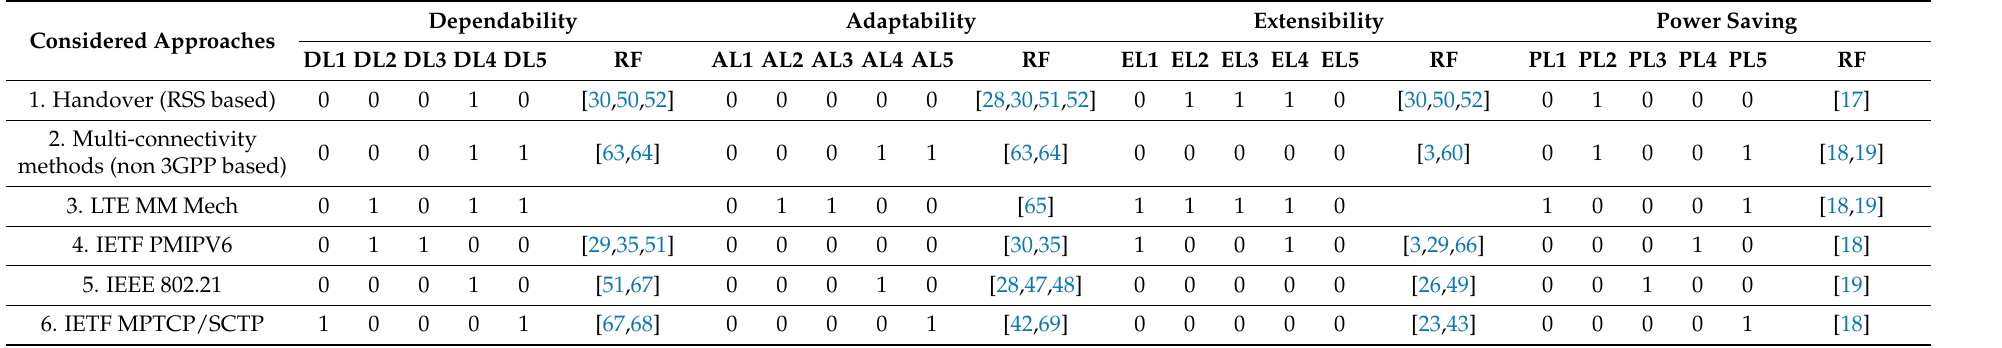
Table 3. Compliance with dependability, adaptability, extensibility, and power